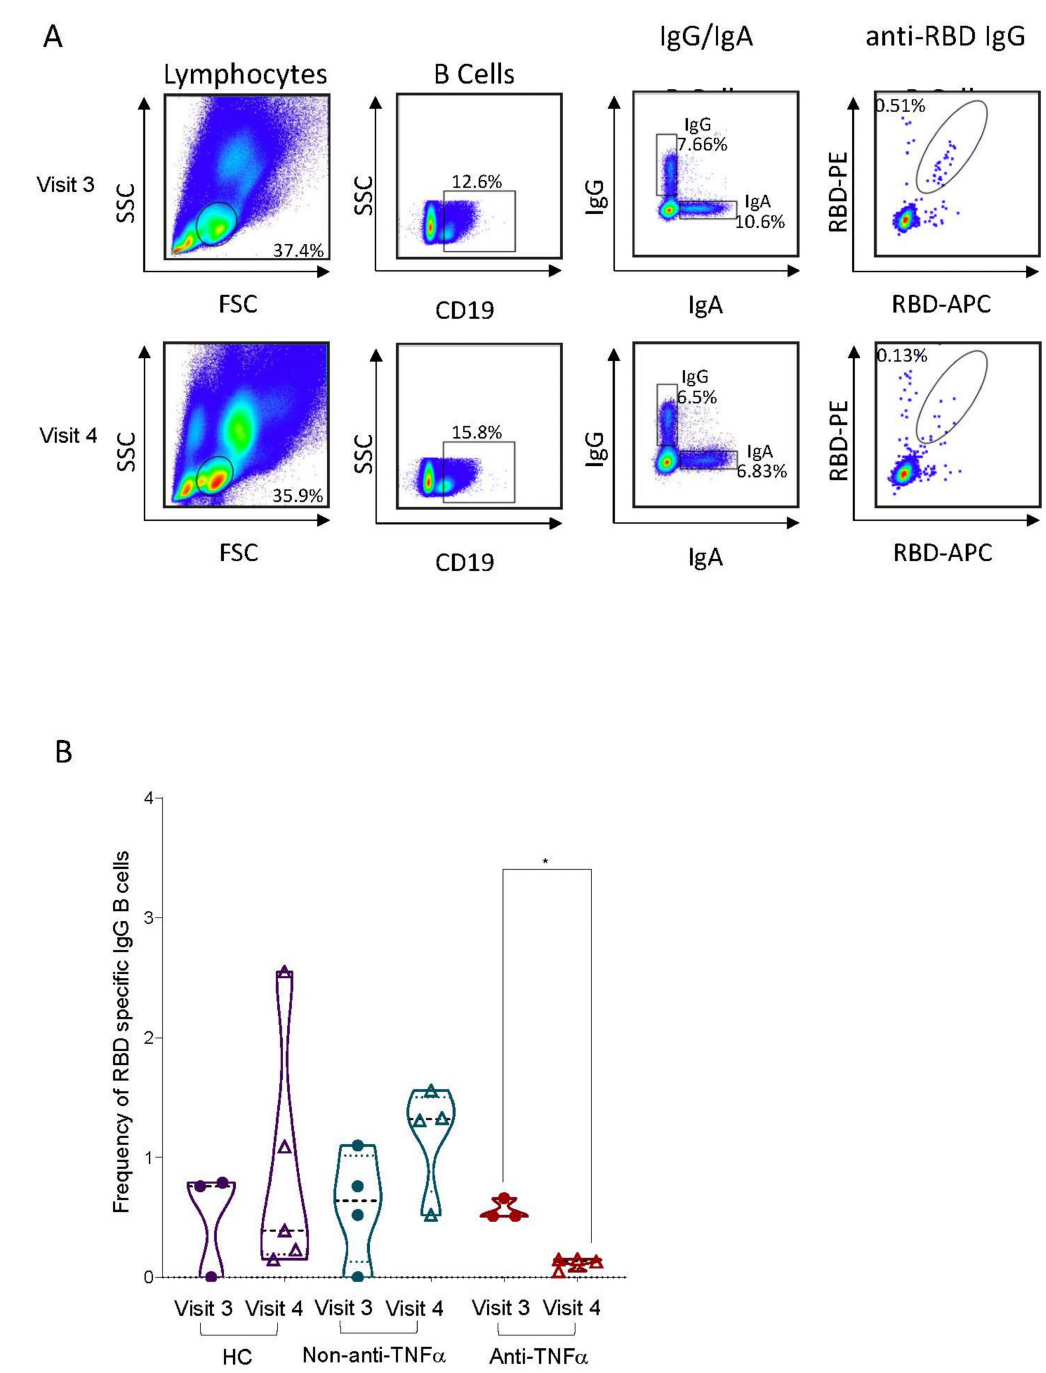
Figure 5. Significant reduction in peripheral RBD-specific IgG B cells over time in patients with IBD treated with anti-TNF α . ( A ) A representative gating strategy and population prevalence from flow cytometry assay at 1 and 6 months post vaccination (visit 3 and 4, respectively). ( B ) Frequency of RBD-specific IgG B cells out of peripheral IgG B cells from healthy controls (HC, shown in purple), patients with IBD receiving non-anti-TNF α treatment (non-anti-TNF α , shown in blue) and patients with IBD receiving anti-TNF α treatment (anti-TNF α , shown in red) following vaccination. Each column was separated into two columns, visit 3 and visit 4, PBMC samples from 1 and 6 months after second vaccine dose, respectively. Statistical analysis was carried out using paired mixed-effect ANOVA to compare frequencies over time for each group (*— p <